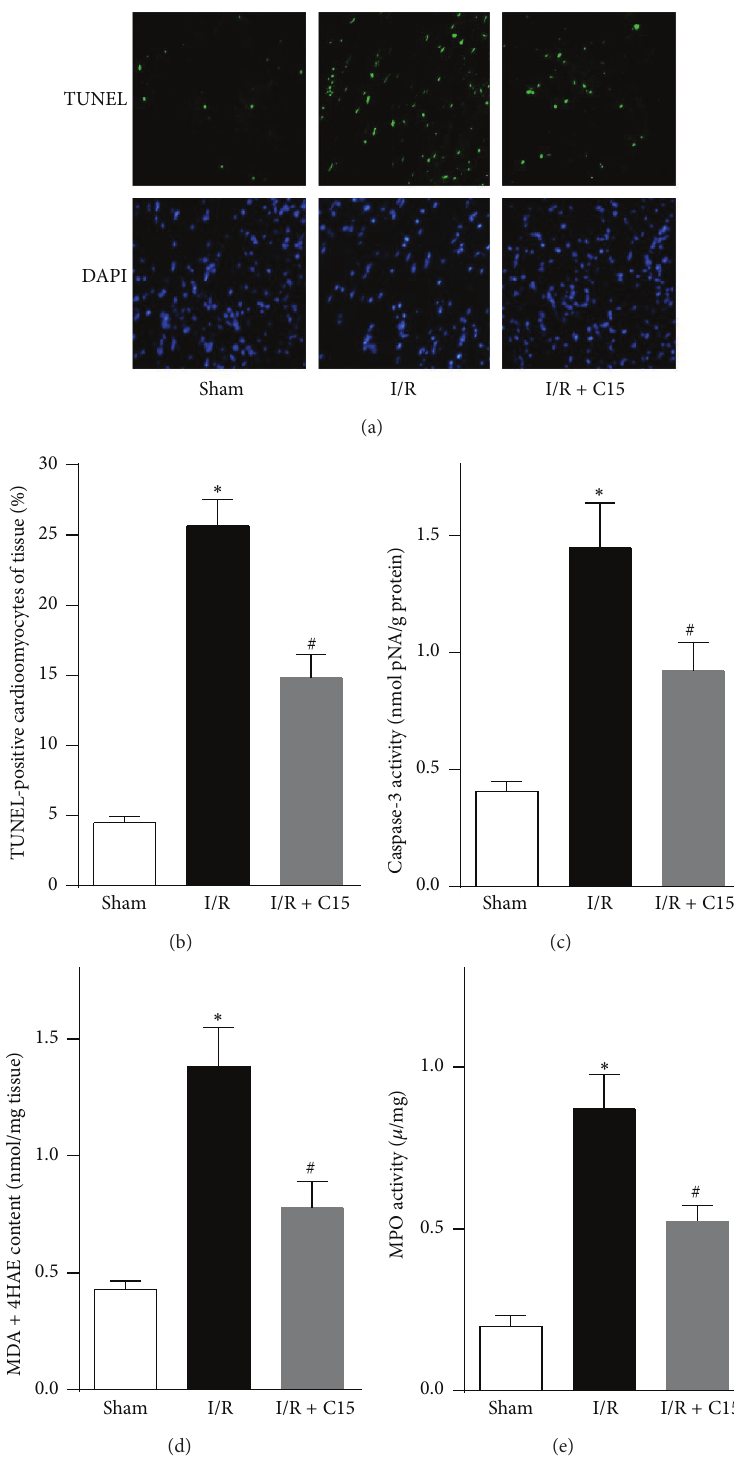
Figure 2: C15 reduced cardiomyocyte apoptosis and neutrophil infiltration. (a) Representative photographs of terminal deoxynucleotidyl transferase-mediated dUTP nick end labeling- (TUNEL-) stained ischemic area 24 h after reperfusion. For these images, apoptotic nuclei are indicated by TUNEL staining (green), and total nuclei are indicated by 4,6-diamidino-2-phenylindole (DAPI) staining (blue); bar, 10 𝜇 m. (b) Quantitative analysis of TUNEL-positive nuclei over the total number of nuclei in vivo ( 𝑛 = 6 ). (c) Caspase-3 activity in the ischemic myocardium was assessed after 24 h of reperfusion ( 𝑛 = 5 ). (d) Malonaldehyde+4-hydroxy-alkenals (MDA+4HAE) contents in the ischemic myocardium were evaluated using a lipid peroxidation assay ( 𝑛 = 5 ). (e) Cardiac myeloperoxidase (MPO) activity was detected in ischemic myocardia ( 𝑛 = 6 ). ∗ < 0.05 versus the sham group; # < 0.05 versus the I/R